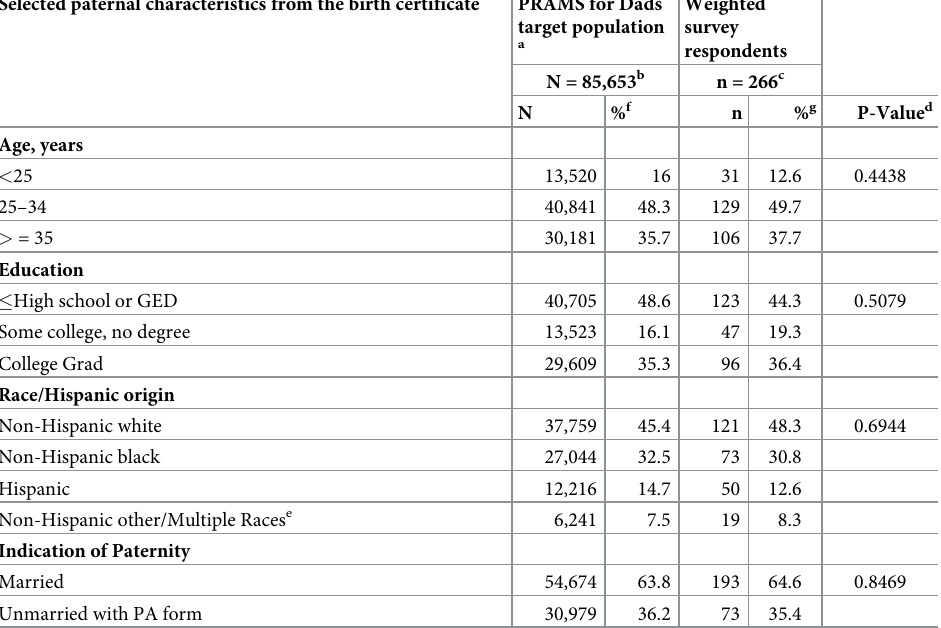
Table 1. Comparison of selected paternal characteristics of the PRAMS for Dads pilot study target population and weighted survey respondents, October 2018–July 2019, Georgia, USA. Selected paternal characteristics from the birth certificate PRAMS for Dads target